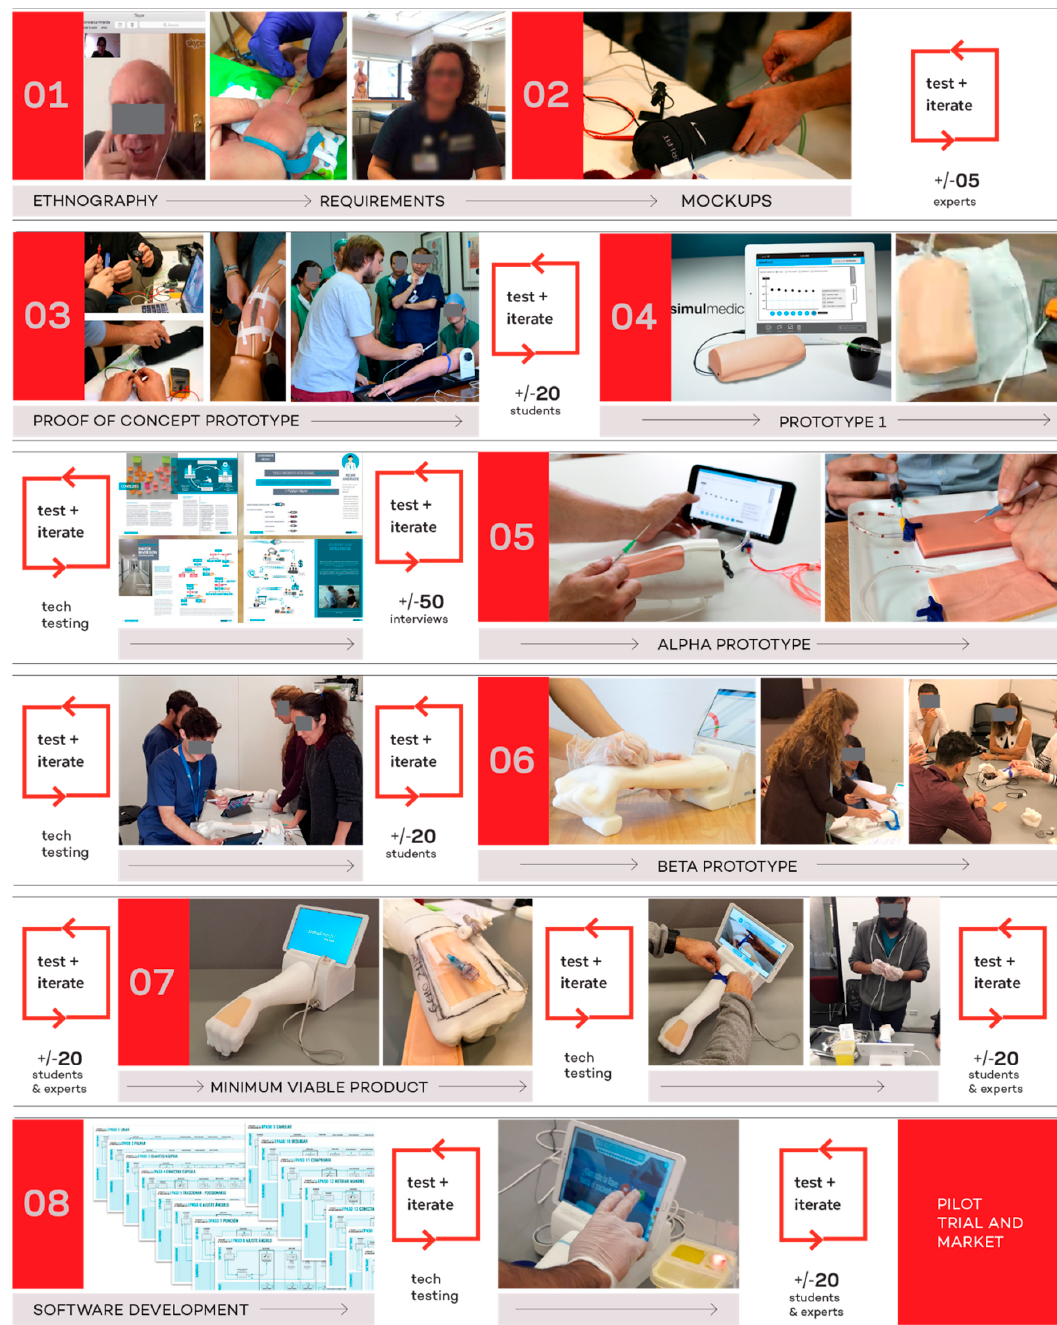
Figure 5. Process for development of the Peripheral Access Simulator between 2014 and 2019.